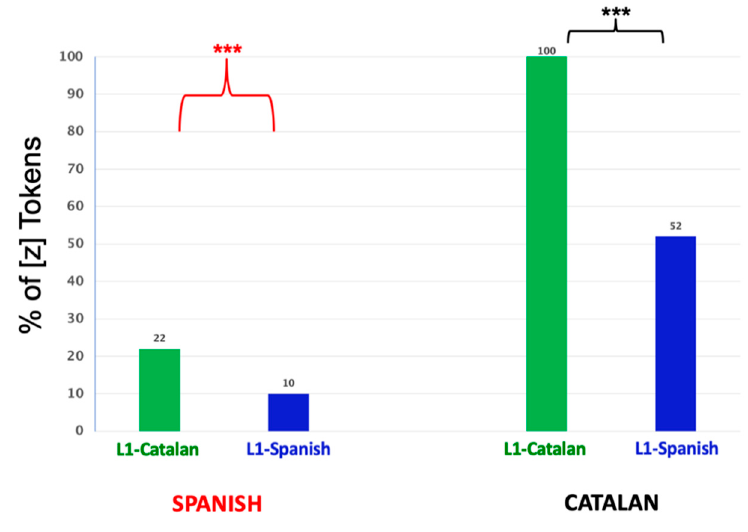
Figure 6. Effects of language profile and language on Barcelonan fricative production.